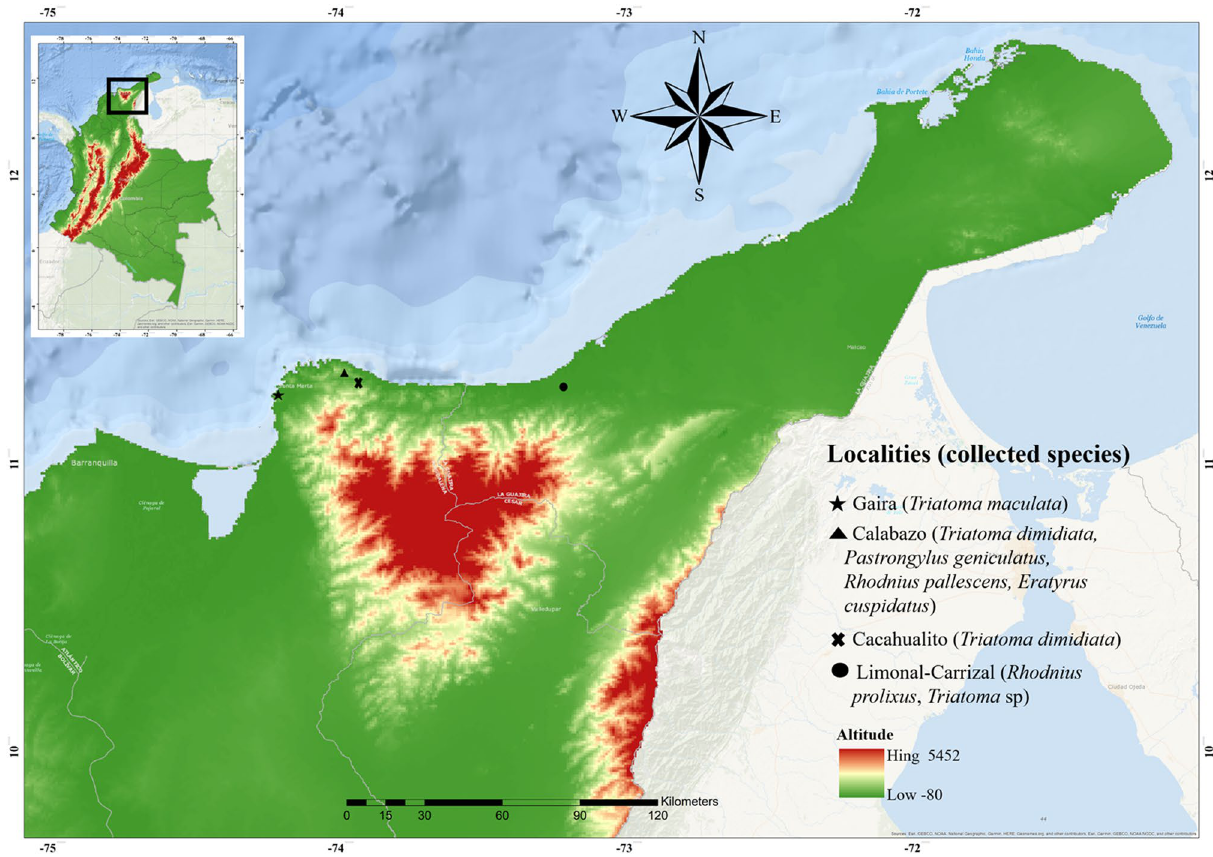
Figure 1. Map of the study area. Triatomine collections were performed in the indicated localities of the SNSM region. Insert: map of Colombia. This map was created in QGIS 3.4 (https:// www. qgis. org/ en/